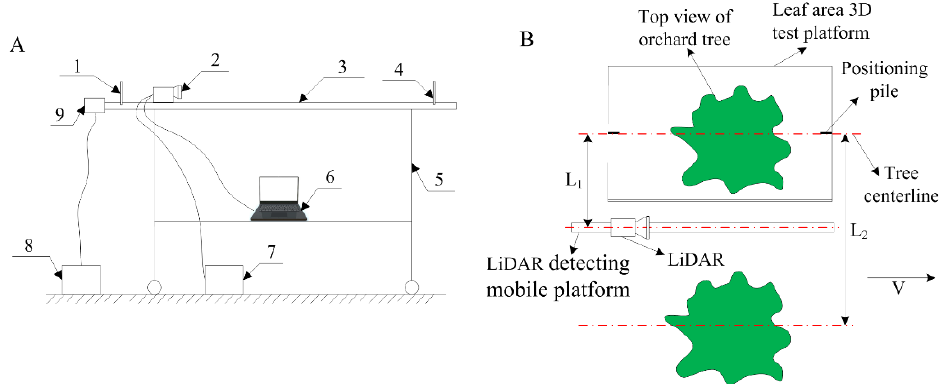
Figure 4. LiDAR detection mobile platform and schematic diagram: ( A ) schematic diagram, including the starting position of the sign board (1), LiDAR (2), linear rail guide (3), end position of the sign board (4), mobile platform (5), computer (6), power supply (7), stepper motor controller (8), and stepper motor (9); ( B ), LiDAR detection mobile platform operation, top view.